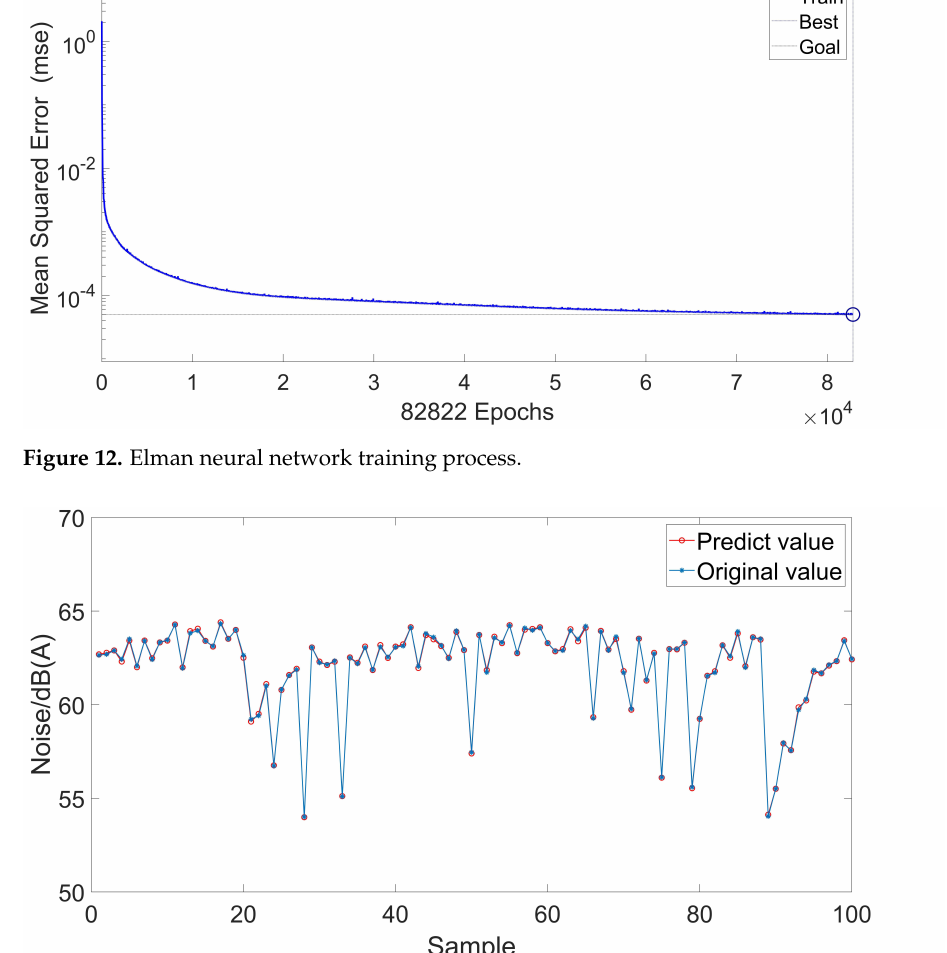
Figure 13. Elman neural network prediction